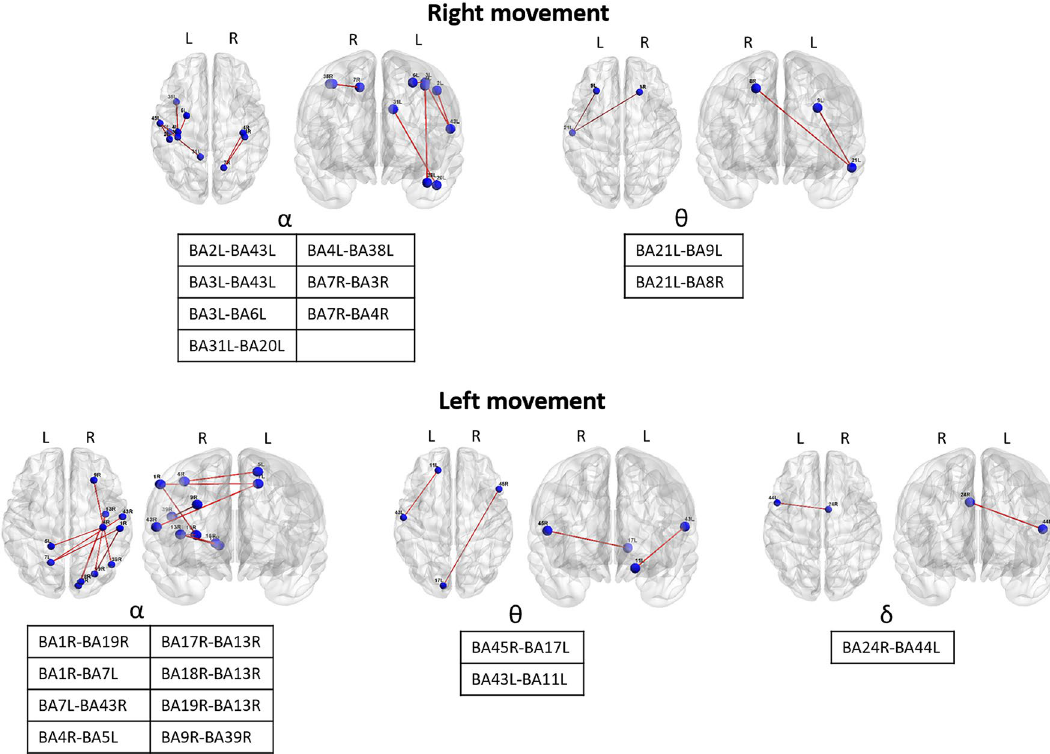
Figure 3. Significant FC links (LLC scores) derived from groups comparison. The figures denote the edges that reduced the strength of connectivity to each node during the movement compared to the resting condition ( p < 0.05, corrected for multiply comparisons) (the figure was obtained with the BrainNet Viewer 1.7 http:// www. nitrc. org/ proje cts/ bnv/).